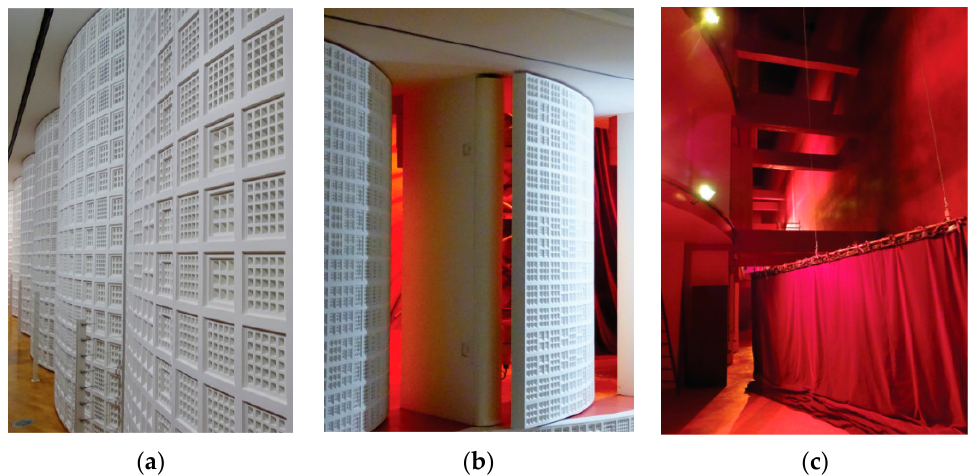
Figure 14. Salle Blanche in Kultur- und Kongresszentrum Luzern—acoustic system: ( a , b ) mobile panels and ( c ) acoustic chamber with the curtain; photograph by B. Majerska-Pałubicka.